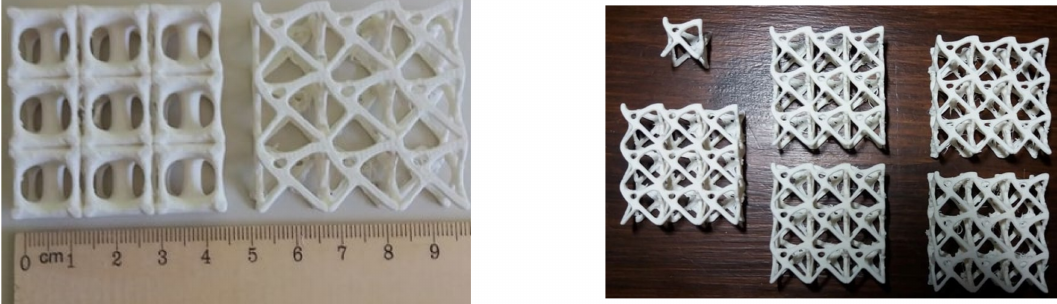
Figure 9. Fabricated ABS specimens without supports for both structures for the tensile strength test with a relative density of 0.4 for structure #1 and 0.1 for structure #2.